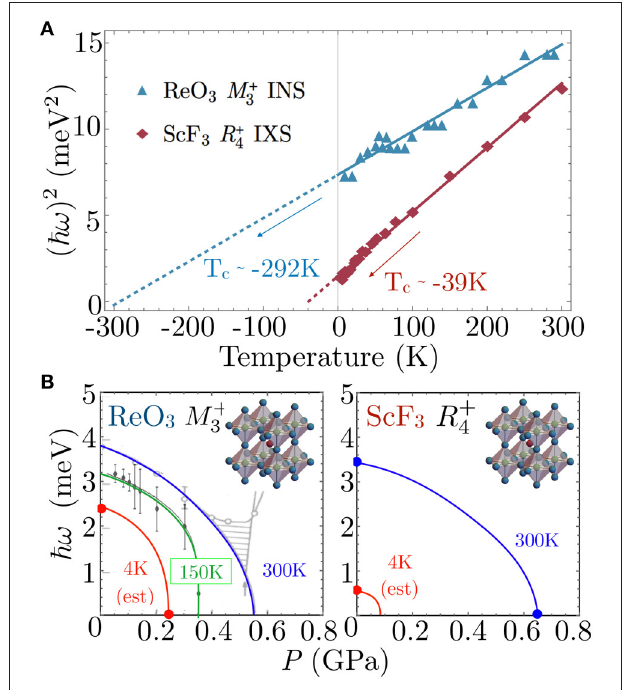
FIGURE 6 | (A) Shows the squared energy ( ¯ h ω ) 2 of the M + 3 and R + 4 soft modes vs. temperature at ambient pressure in ReO 3 and ScF 3 , respectively. As indicated, extrapolation by mean-field approximation (Equation 1) indicates structural transition temperatures at ambient pressure of T c ≃ − 292K for ReO 3 and T c ≃ − 39K for ScF 3 . (B) Shows the soft mode energy vs. pressure at various temperatures for (left) the M + 3 mode in ReO 3 and (right) the R + 4 mode in ScF 3 . Solid lines are guide to the eye and symbols in both (A,B) are taken from references ( Axe et al., 1985; Chatterji et al., 2009a; Handunkanda et al., 2015). Comparison supports our assignment that ScF 3 is closer to a SQPT than ReO 3